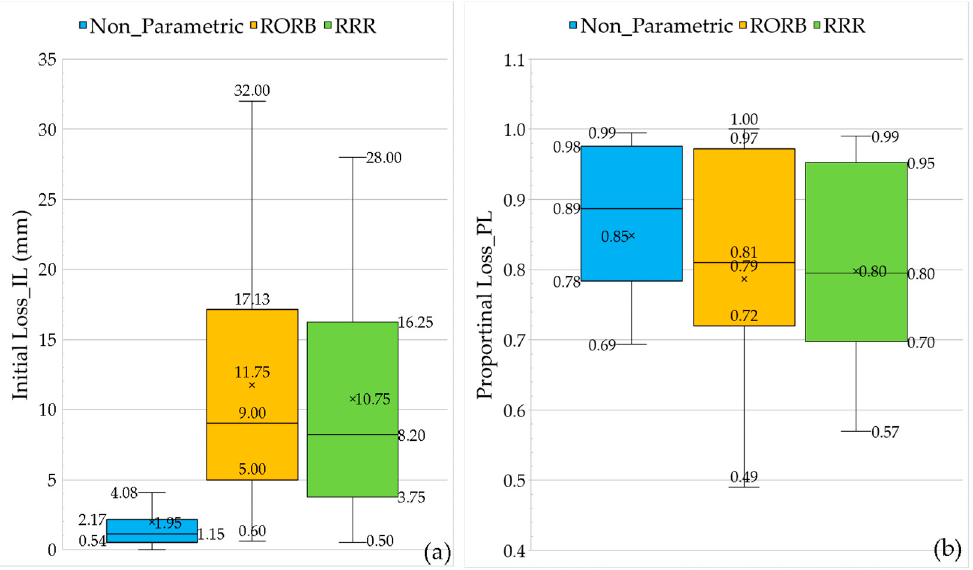
Figure 8 . Box plot of ( a ) IL ( b ) PL for rural portion . Figure 8. Box plot of ( a ) IL ( b ) PL for rural